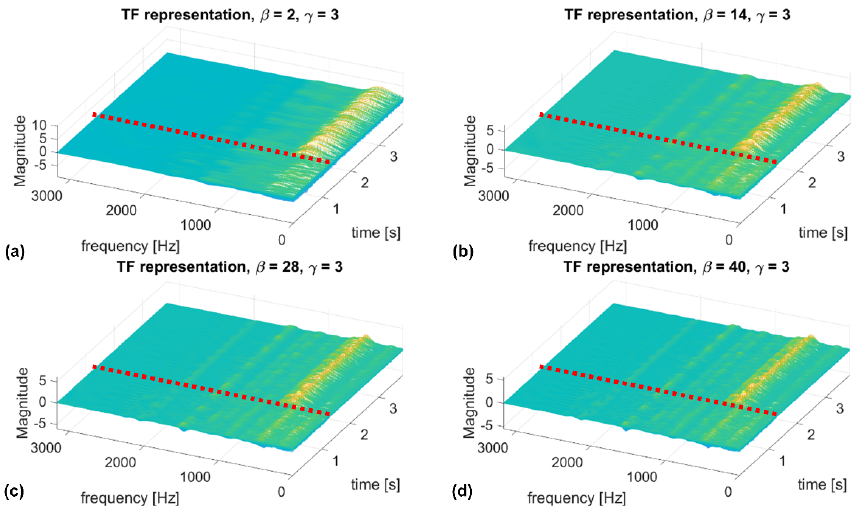
Figure 5. Time–frequency distributions corresponding to the results shown in Figure 4 ( 𝛾 = 3 and 𝛽 equal to ( a ) 2, ( b ) 14 , ( c ) 28 , and ( d ) 40).